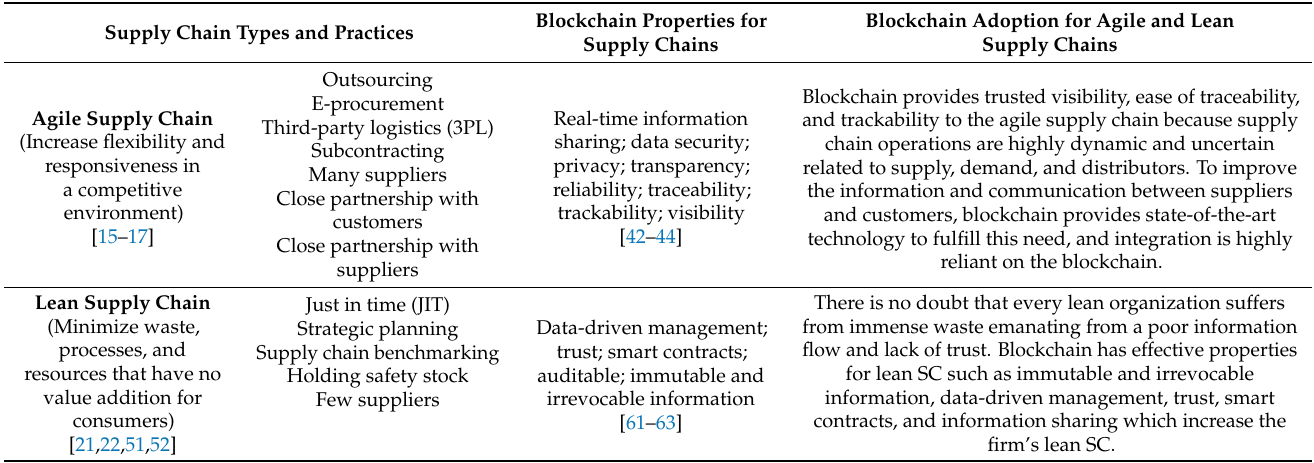
Table 1. Blockchain properties and implications for agile and lean supply